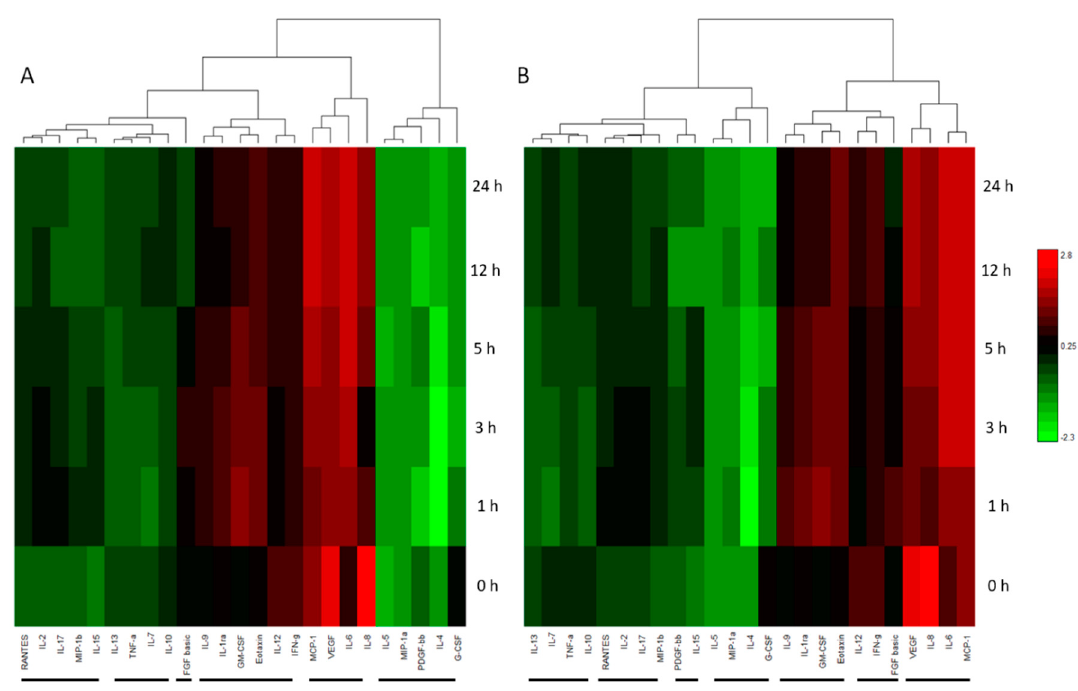
Figure 4. Hierarchical correlation and grouping of up/down regulated cytokines and interleukins secretions from basal ADSCs and temporal differentiation with ( A ) AECK neural differentiation media ( B ) LK neural differentiation media. Hierarchical clustering by Euclidean test Red: expression above median; Green: expression below the median; Black: median expression across all samples.